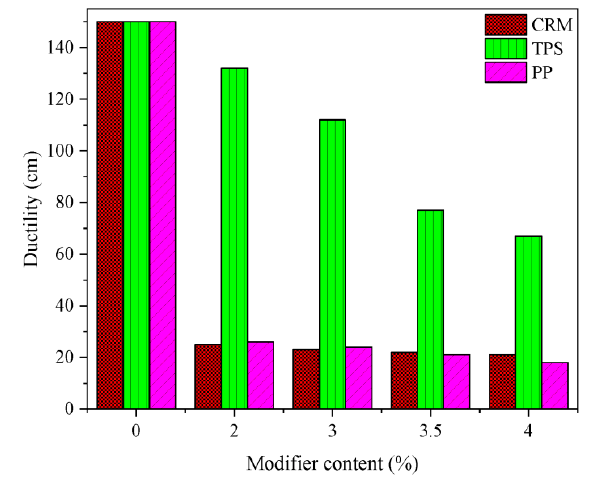
Figure 2. Effect of modifier content on ductility. Figure 2. E ff ect of modifier content on